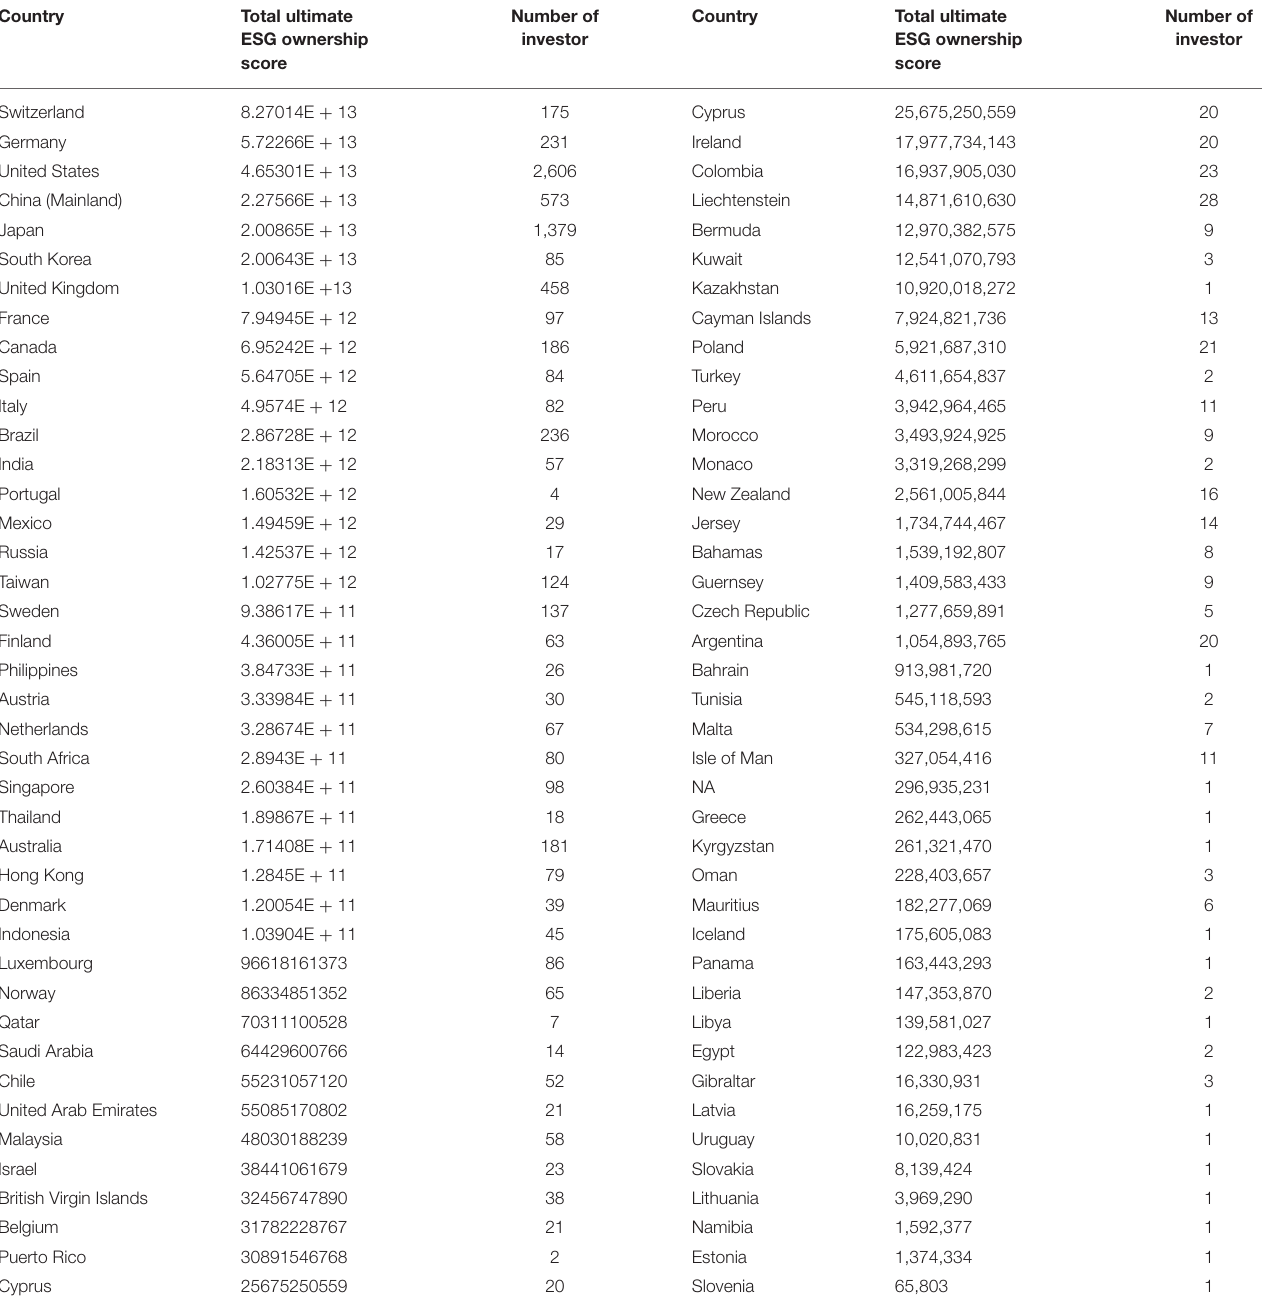
TABLE 2 | Total ultimate ESG ownership score by